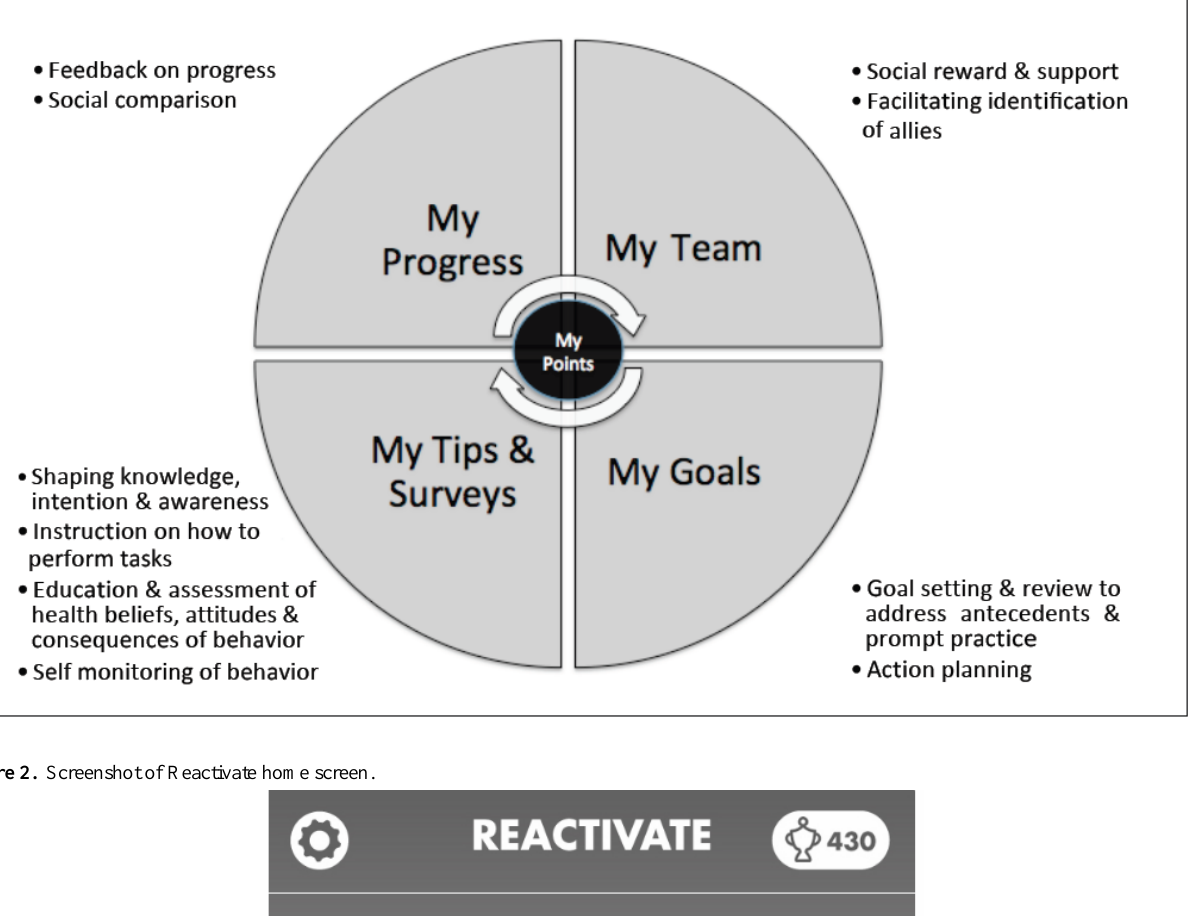
Figure 1. Schematic of Reactivate behavioral change components.